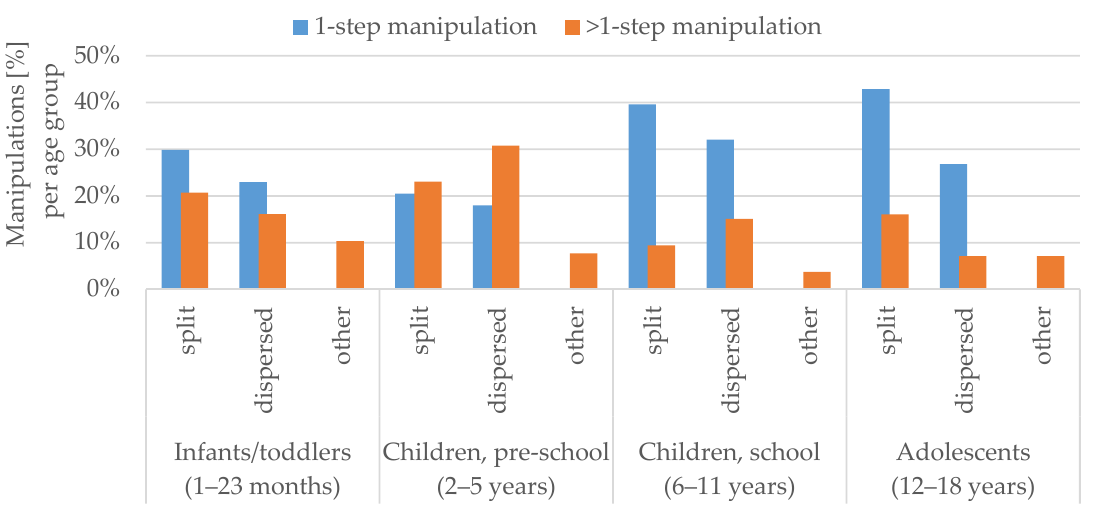
Figure 5. Root causes for manipulation (%) per age group.